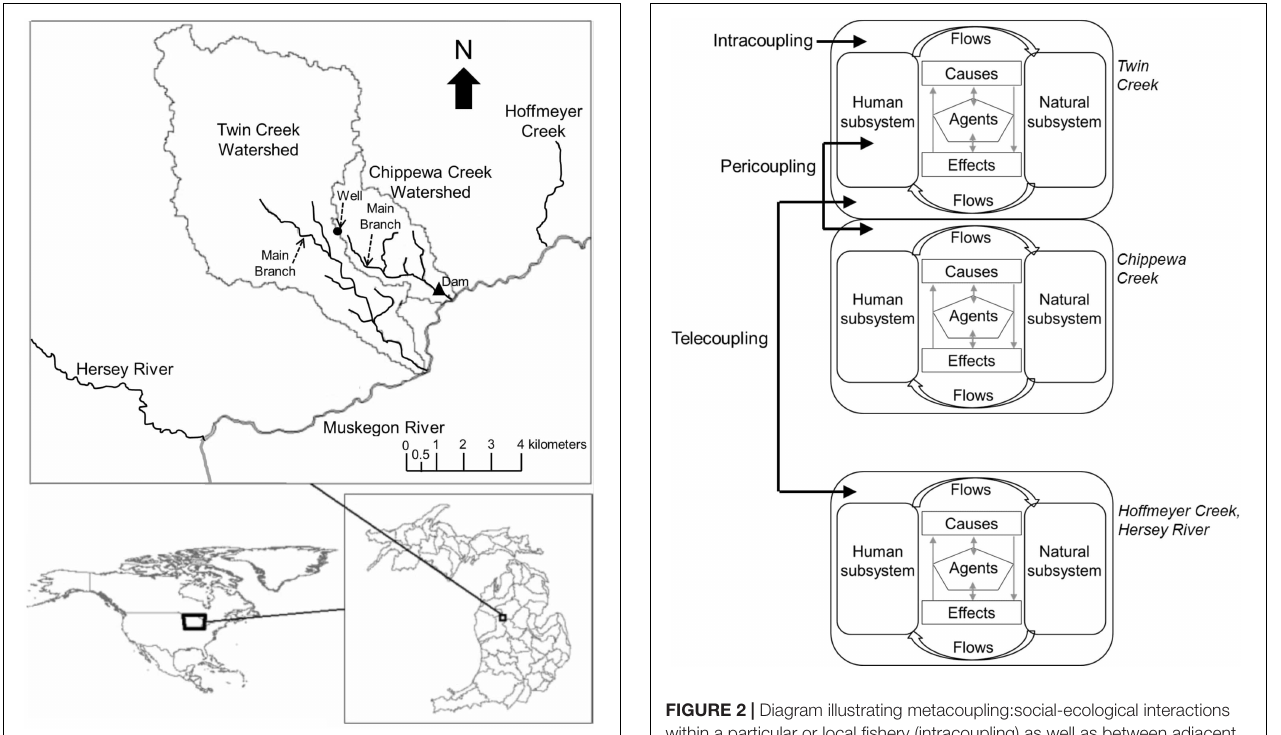
FIGURE 1 | Map of the study area, including the Twin and Chippewa creek watersheds, Hoffmeyer Creek, and the Hersey River in Osceola County, MI, United States. The black circle denotes a large-capacity (0.0040 m 3 /s, 100,000 gallons per day) groundwater well owned by Nestlé Water North America. The black triangle shows a dam in the lower portion of Chippewa Creek that prevents upstream fish movement.